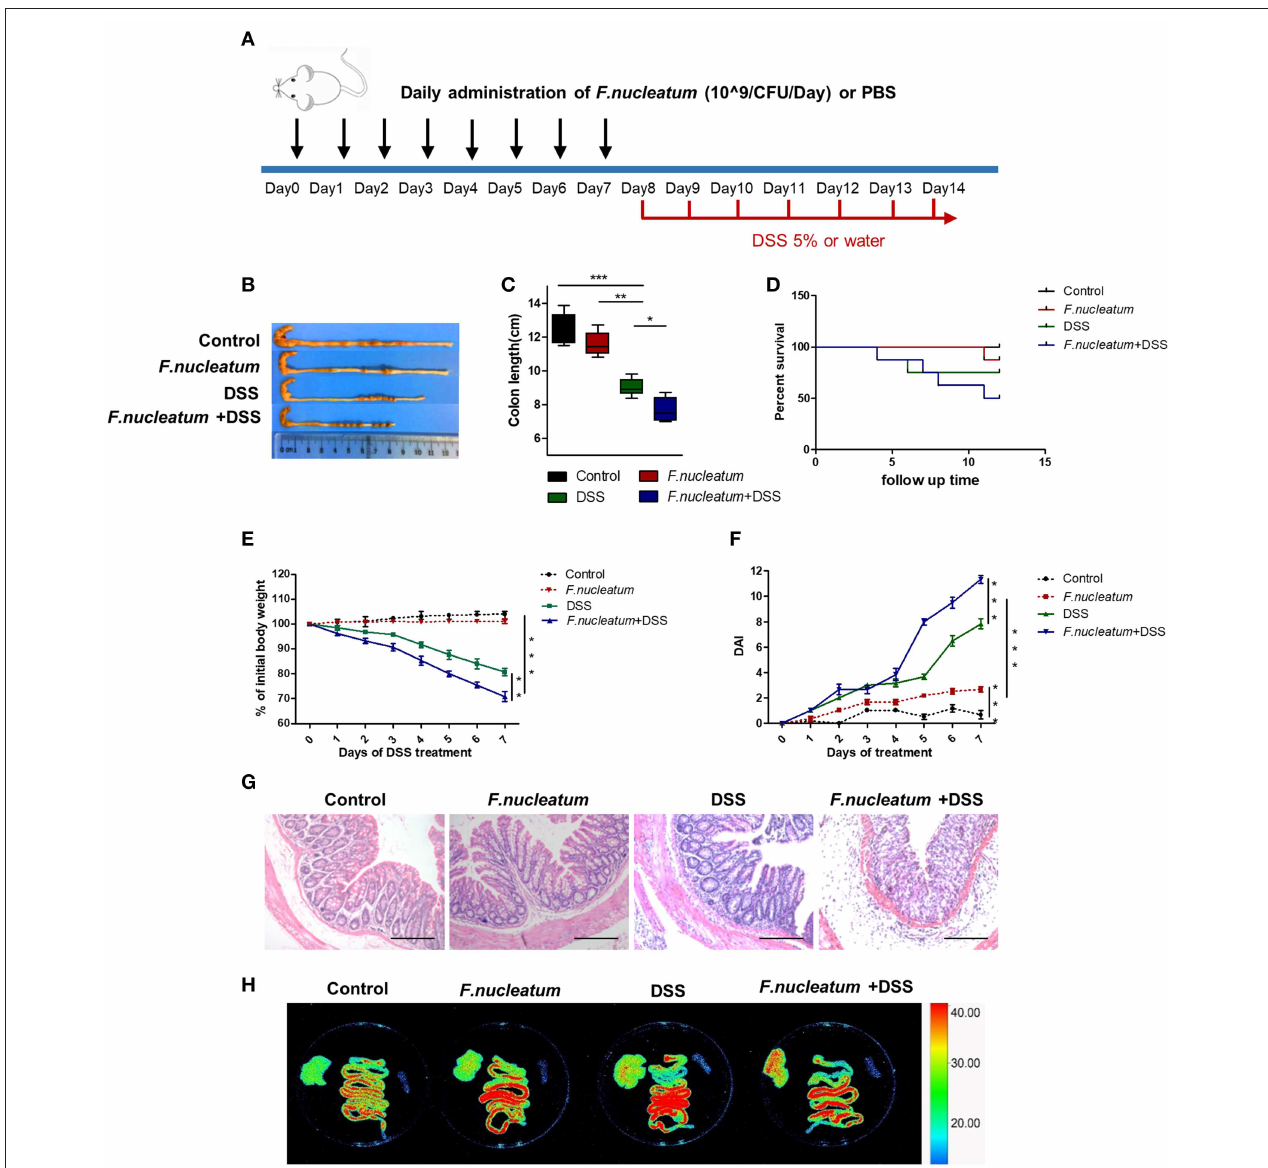
FIGURE 2 | F. nucleatum increased the susceptibility of mice to DSS-induced experimental colitis. BABL/C mice were subjected to a DSS-induced colitis induction protocol using 5% DSS in drinking water for 7 consecutive days. (A) F. nucleatum and DSS treatment schedule. (B,C) Macroscopic appearance and quantification of colon length was determined at day 7 after DSS induction of colitis, n = 6 mice per group. Representative images are shown. (D) Survival curves of mice in this system, n = 6 mice per group. (E) Body weights determined daily for all mice, n = 6 mice per group. (F) Daily DAI scores for all mice, n = 6 mice per group. (G) Serial sections of colon tissues were stained with H&E to investigate tissue damage. Representative images are shown. Scale bars, 50 µ m. (H) Ex vivo images of the liver, spleen, and intestine 12h after gavage of mice with ERFP- E.coli . Representative images are shown. Each experiment was performed at least three times. Data are presented as means ± SD. * P < 0.05; ** P < 0.01; *** P < 0.001; Analysis of Variance (ANOVA) and Student’s t -test (two-tailed).